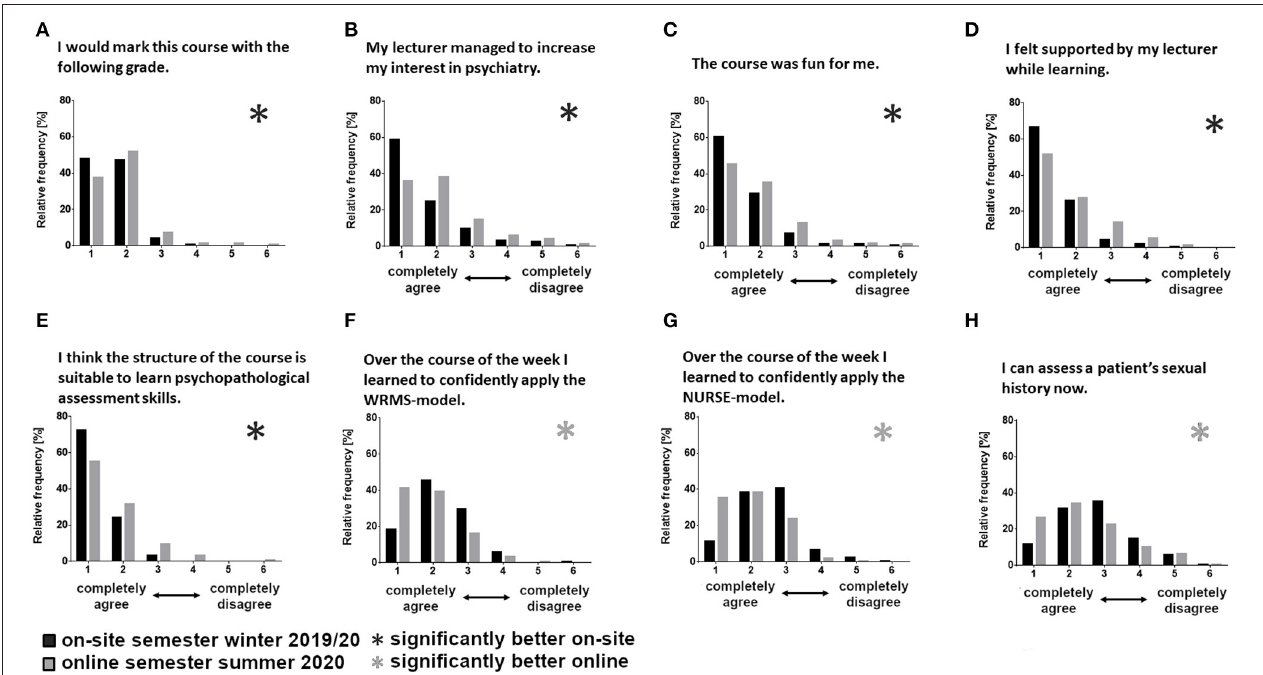
FIGURE 2 | Distribution of questionnaire ratings sorted by item (A–H) , comparing between the semesters (winter semester 2019/20, n = 150; summer semester 2020, n = 156) using hierarchic linear modeling (*significant differences between the semesters; WRMS, Wait-Repeat-Mirror-Summarize-Model; NURSE,